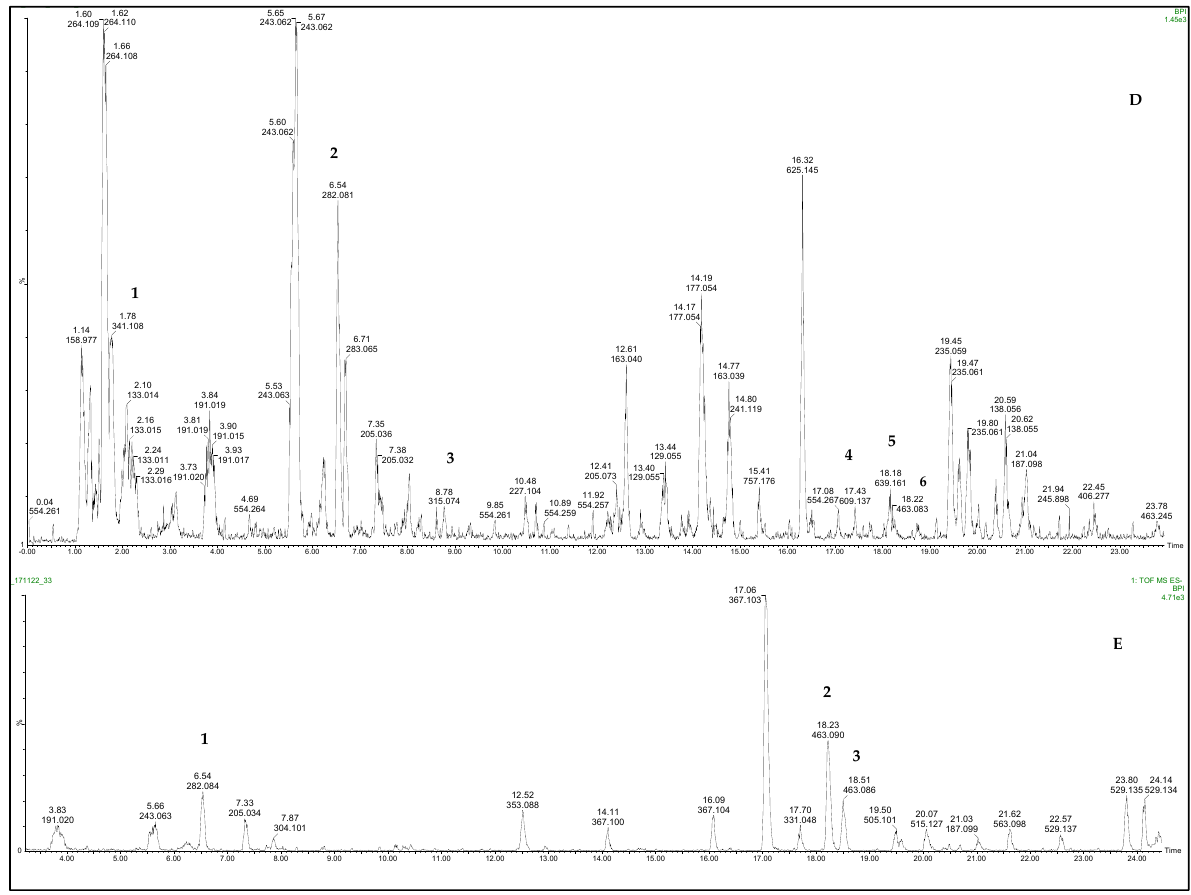
Figure 1. Chromatograms of spider plant ( A ), swiss chard ( B ), pumpkin ( C ), cowpea ( D ), and jute mallow ( E ). Table 5. Molecules identified in spider plant and four standards (swiss chard, jute mallow, cowpea, and pumpkin).